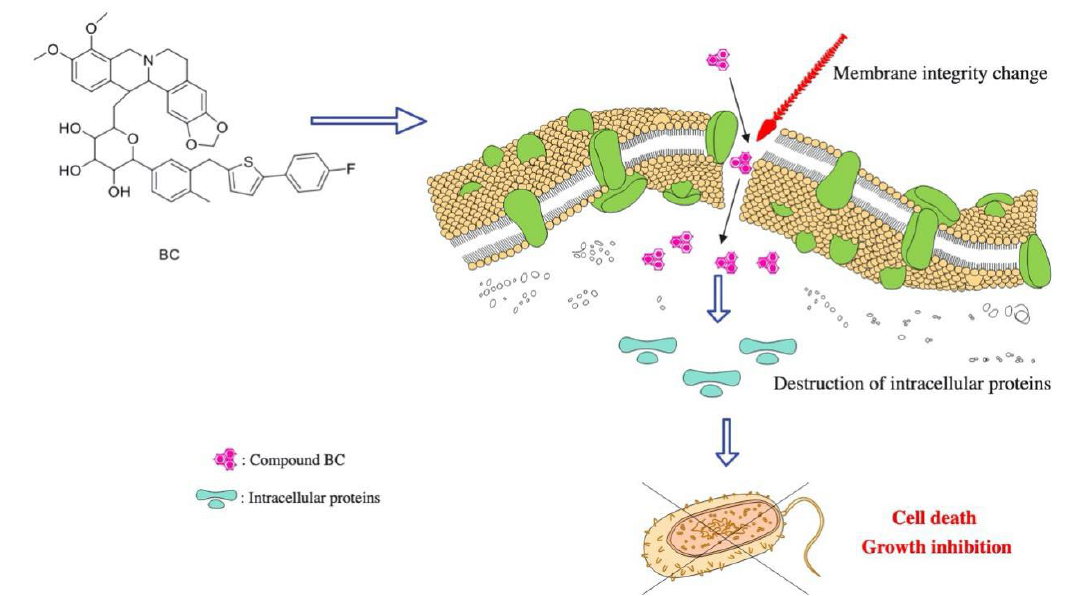
Figure 9. Bactericidal mechanism of compound